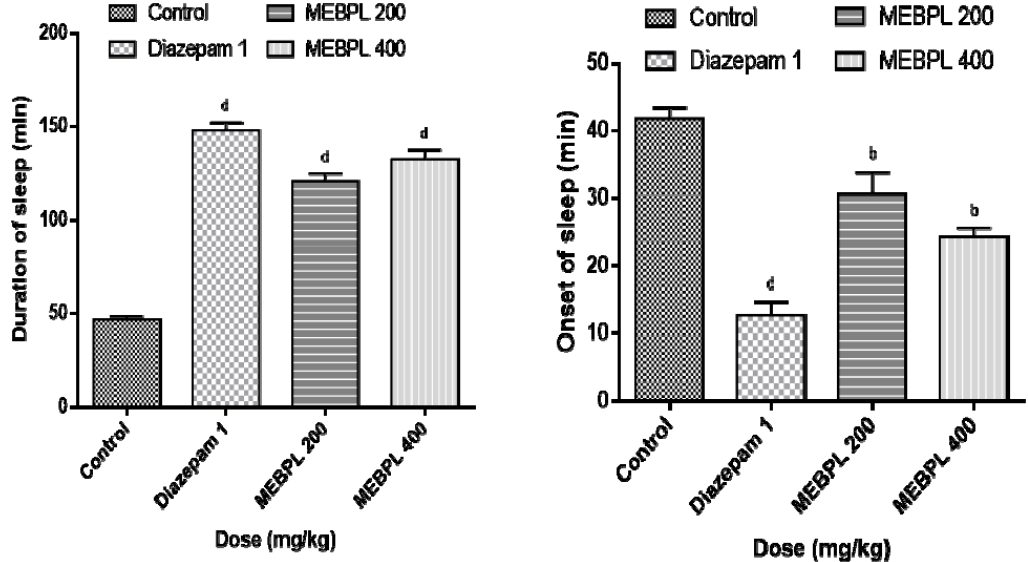
Figure 4. Sedative effect of methanol extract of B. pilosa leaves (MEBPL) by using thiopental sodium induced sleeping time test. Values are stated as mean ± SEM ( n = 5). b p < 0.01 and d p < 0.0001 compared with control group followed by Dunnett’s test of one-way ANOVA (GraphPad Prism 6.0).